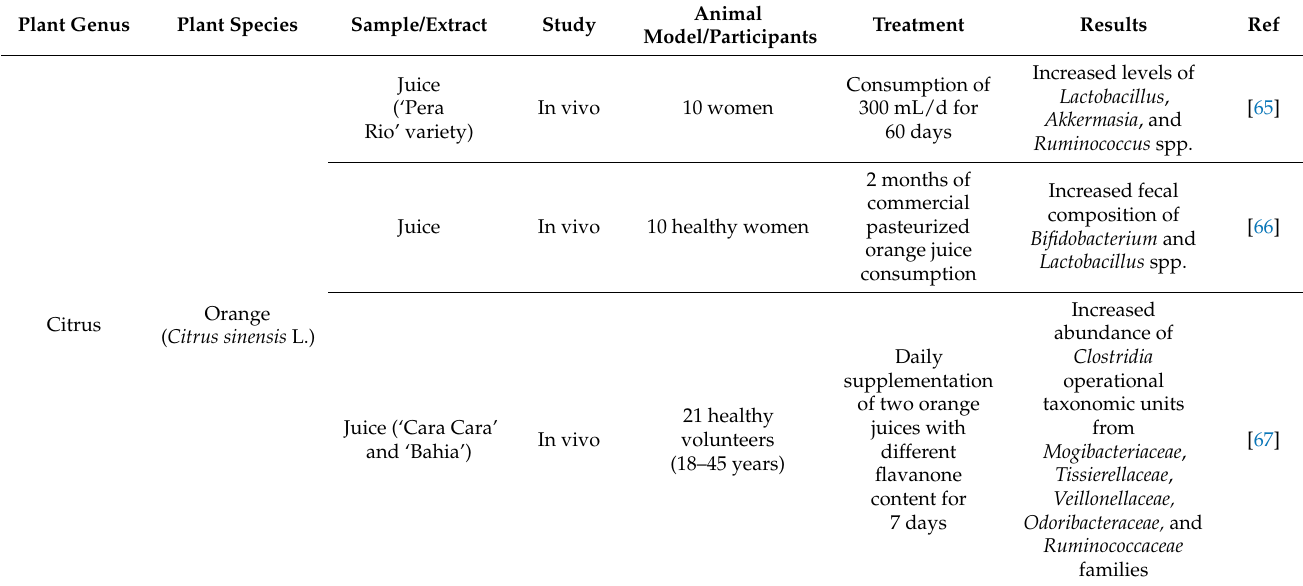
Figure 1. The gut microbiota dysbiosis process and potential role of fruits, their juices, and freeze- dried powders on IBD. Table 1. Fruit species investigated for their potential beneficial role on gut